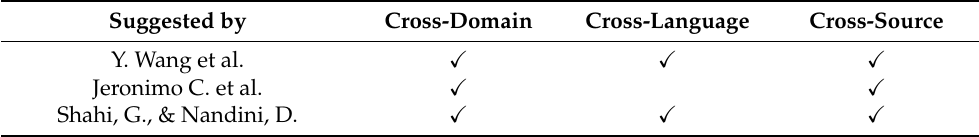
Table 18. Cross-Categories of Multi-Cross